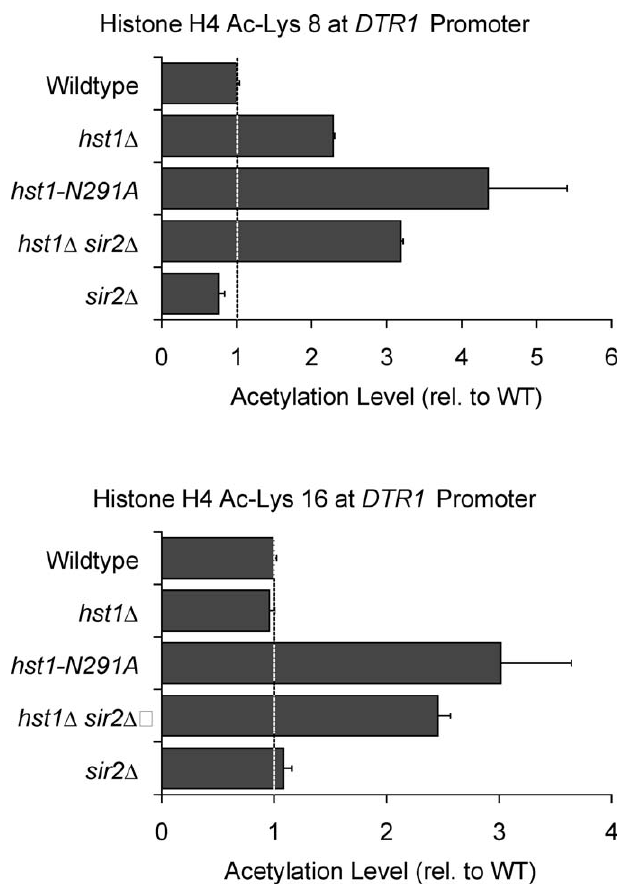
Figure 3. Histone H4 K8 and K16 Acetylation at the DTR1 Promoter Increases in the Absence of Deacetylase Activity The relative levels of acetylation of H4 K8 and H4 K16 were determined in wild-type (W3031-a), hst1 D (LRY198), hst1 - N291A (LRY1306), hst1 D sir2 D (LRY333), and sir2 D (LRY1079) backgrounds at the DTR1 promoter (B primers). Histone H4 K8-Ac and K16-Ac enrichment at DTR1 was normalized to the repressed promoter of PHO5 as well as for total histone H4 occupancy and quantified relative to the wild-type